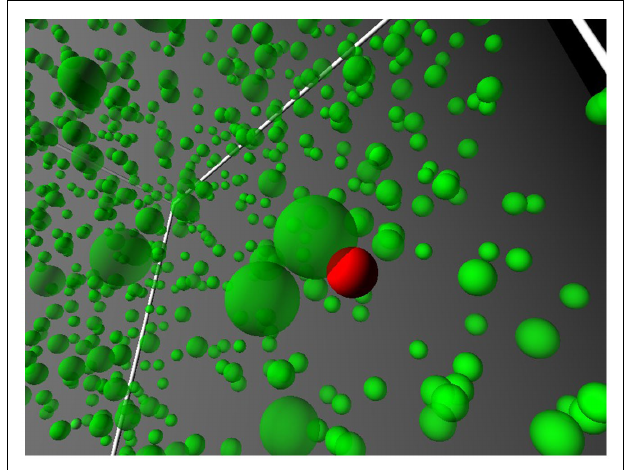
FIGURE 4 | Schematic illustration of a continuous 3D spatial environment in silico within an agent-based model. Spherical objects represent cells, the different colors depict different cell